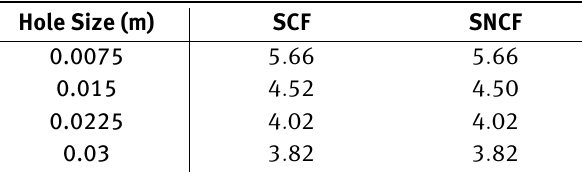
Table 3: Effect of hole size on stress and strain concentration factors Hole Size